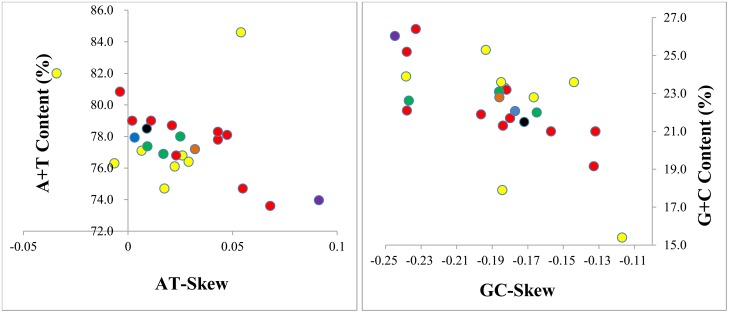
AT% vs AT-Skew and GC% vs GC-Skew in Diptera mitochondrial genomes.Measured in bp percentage (Y-axis) and level of nucleotide skew (X-axis). Values are calculated on full length mitochondrial genomes. Orange circle, Diptera; red circle, Muscomorpha; yellow circle, Tipulomorpha; Green circle, Culicomorpha; blue circle, Tabanomorpha; black circle, Delia antiqua (Anthomyiidae).